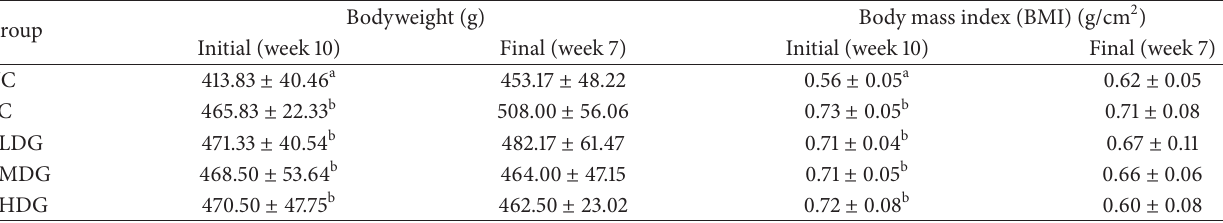
Table 3: Mean of body weight and body mass index (BMI) of rats after the obesity induction week (week 10) and after treatment week (week 7).